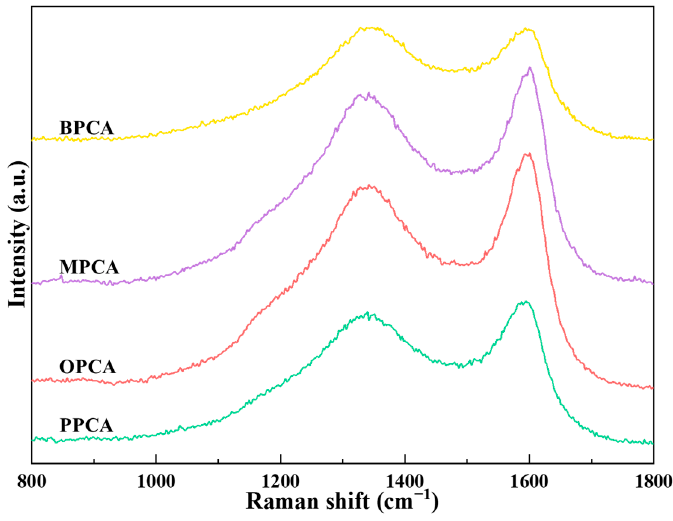
Figure 4. Raman spectrums of CAs prepared from different waste biomasses.